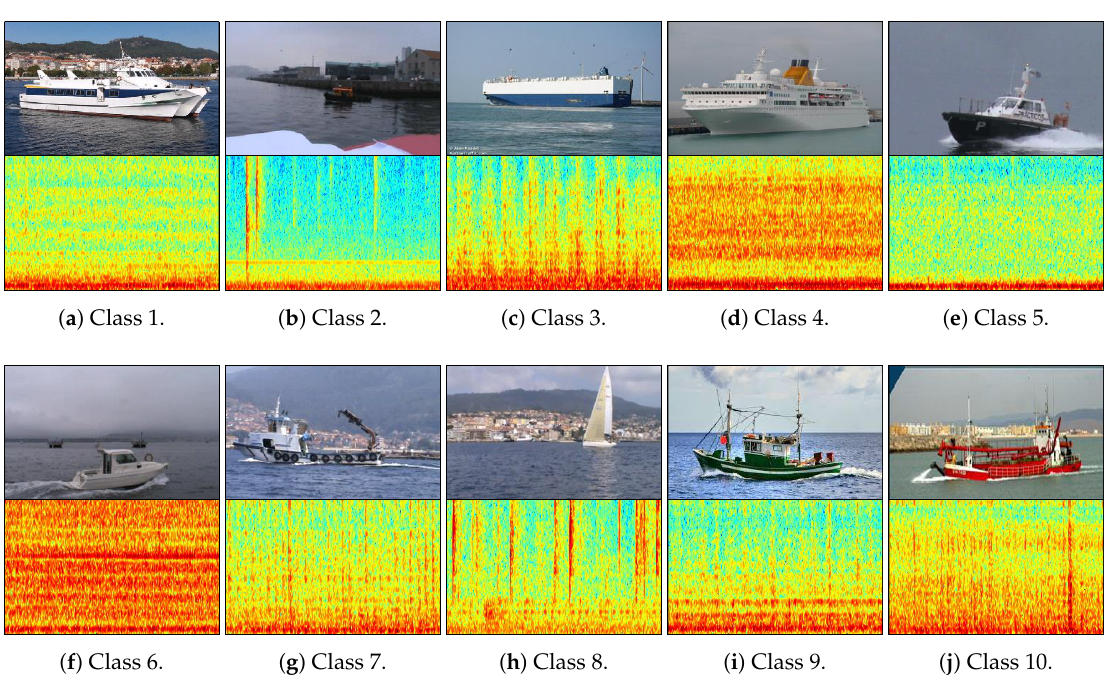
Figure 3. Random samples of spectrogram and pictures in each class of